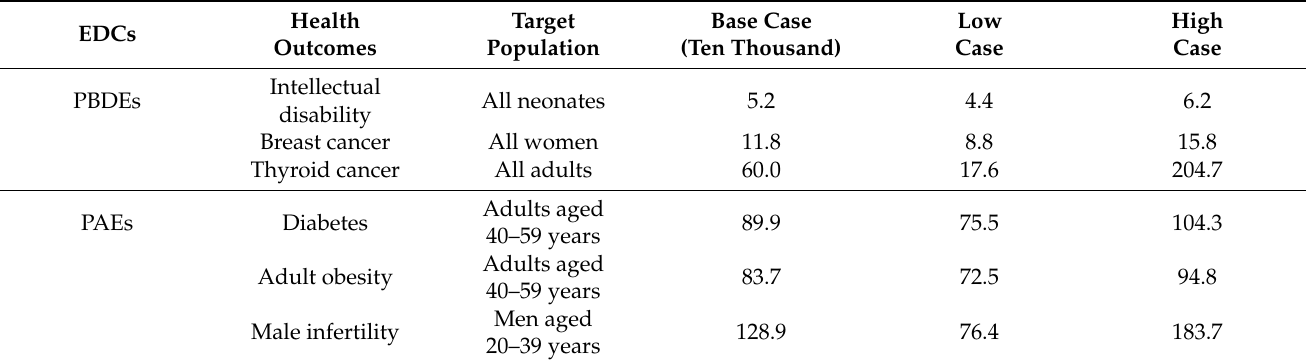
Table 1. Attributable disease burden caused by PBDEs and PAEs in the general Chinese population in 2015.